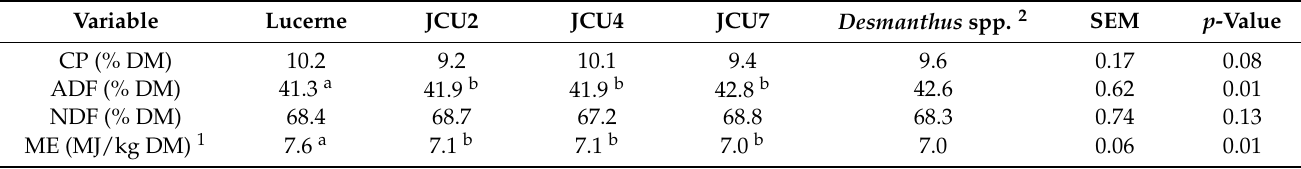
1 Estimated as DMD × 0.172 − 1.707 [31], 2 average of the three Desmanthus spp. DM = dry matter, CP = crude protein, ADF = acid detergent fiber, NDF = neutral detergent fiber, ME = metabolizable energy, SEM = standard error of the mean. Means within the same row without the same alphabetical characters ( a,b ) represent statistical differences ( p <